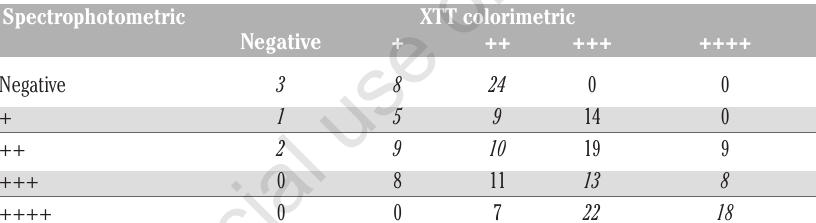
Figure 1. The distribution of biofilm production rate among Candida species. This Figure was constituted by using the compatible results of two different biofilm detection meth- ods (italicized in Table Table 2. The comparison of the biofilm detection methods.